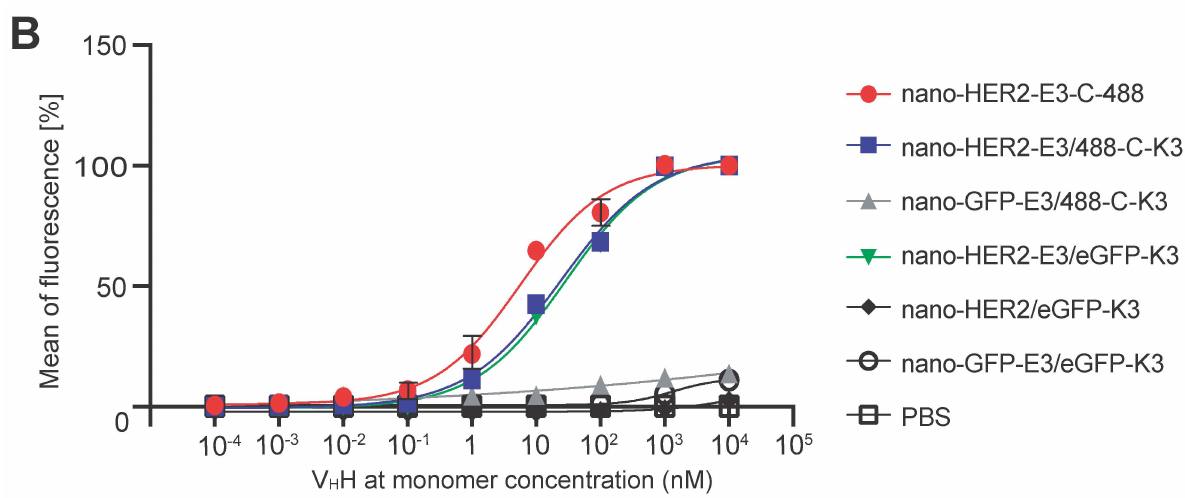
Figure 4. Determination of binding capacity of recombinant nano-HER2-E3 associated with eGFP- K3 or 488-C-K3 on HER2 overexpressing cells. ( A ) Cartoon representation of the heterotetramer biomolecule composed of nano-HER2-E3/eGFP-K3 binding to HER2 cell surface receptor and the positive control nano-HER2-E3-C covalently labeled with Alexa-Fluor-488 maleimide. ( B ) Determi- nation of relative binding affinities of nano-HER2-E3 alone or either co-associated with eGFP-K3 or 488-C-K3 on breast cancer cells. HCC1954 cells were incubated with increasing concentrations of nano-HER2-E3-C-488, nano-HER2-E3/eGFP-K3 or nano-HER2-E3/488-C-K3, or with eGFP-K3 alone as a control. Following incubation, fluorescence was measured by flow cytometry. The relative mean fluorescence was plotted against nanobody concentration (nM), and the apparent K D value was determined using sigmoidal fitting with R software (DRC package, R Core Team GNU GPLu2 version 4.2.1 Columbia, SC,